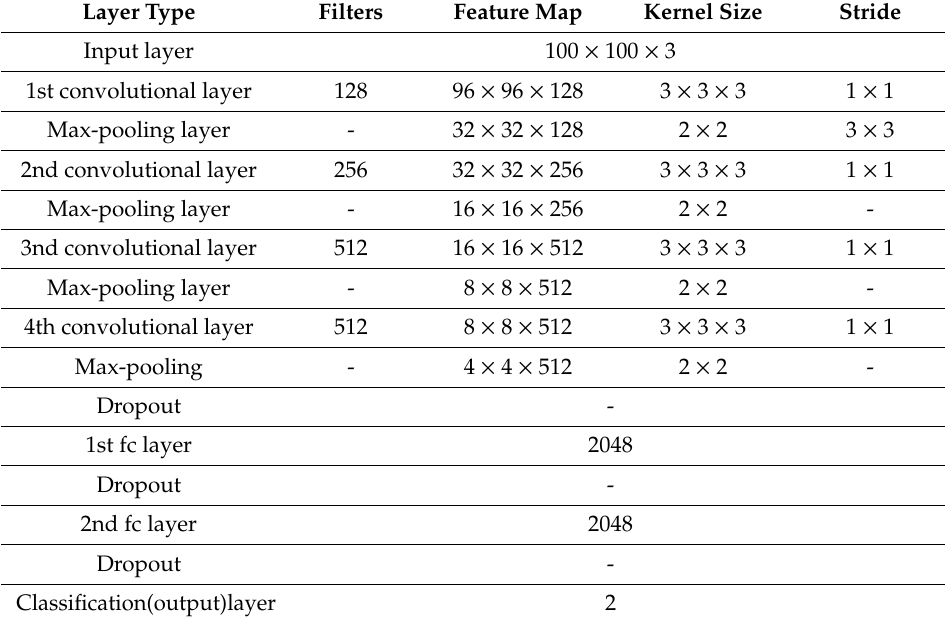
Table 2. Layered network